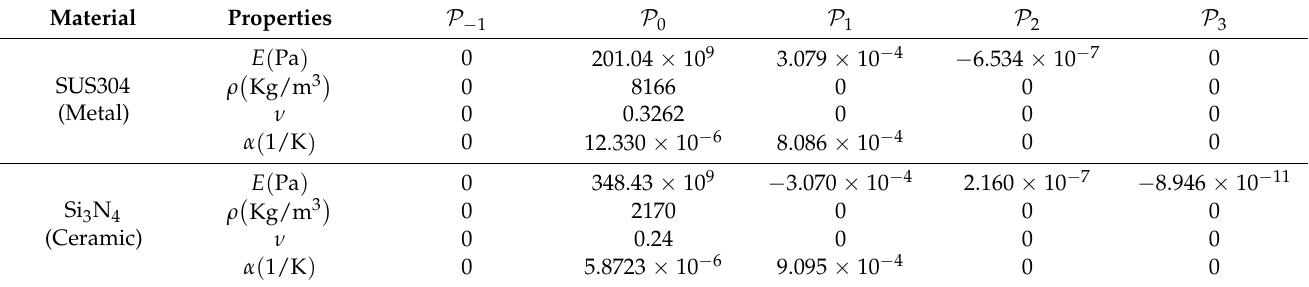
Table 2. Temperature-dependent coefficients for metal (SUS304) and ceramic (Si 3 N 4 ) constituents [71].